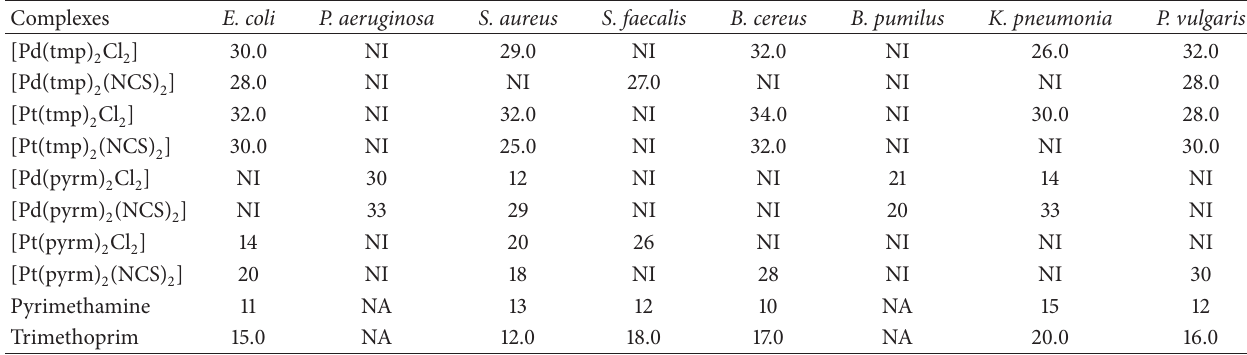
Table 2: Zone of inhibition exhibited by metal complexes at 40 mg/mL (mm). Complexes